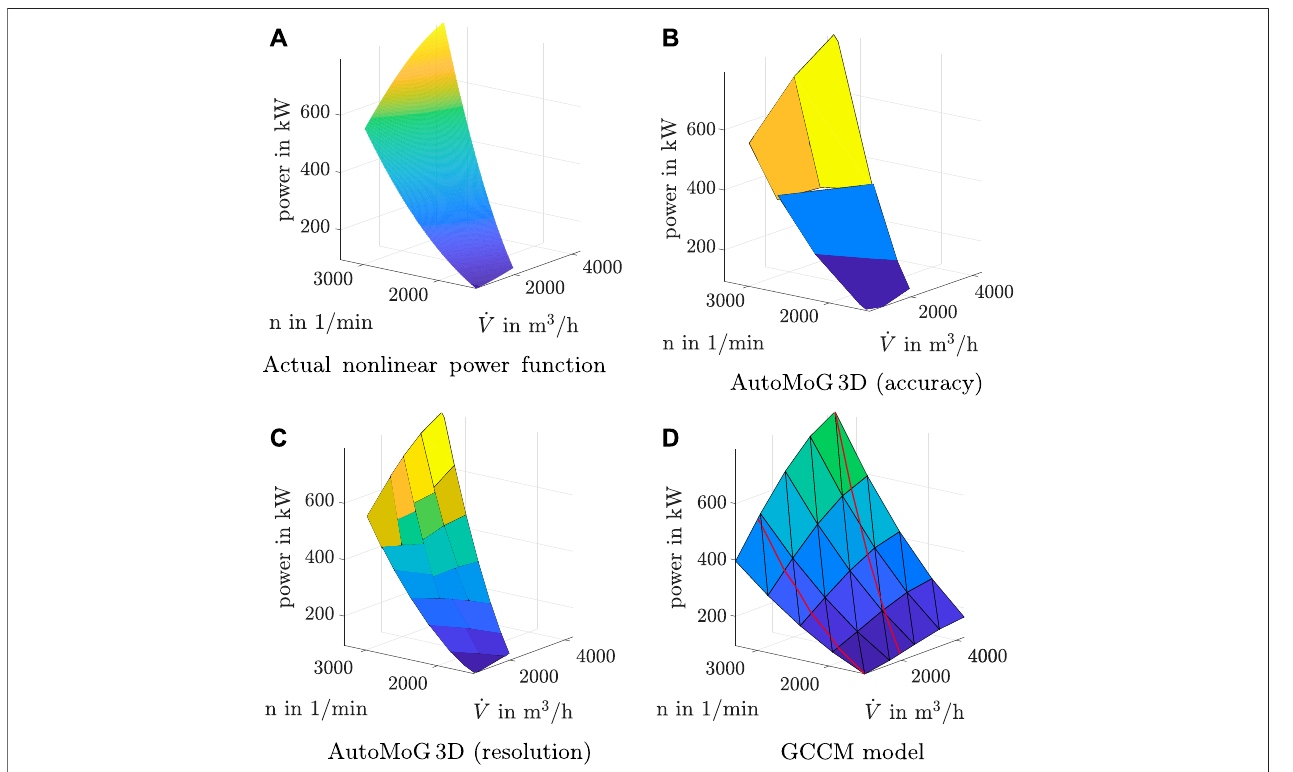
FIGURE 6 | Actual nonlinear power function of a variable-speed pump (A) , AutoMoG3D model with the same accuracy as the model of the generalized-convex- combinationmethod(GCCMmodel) (B) ,AutoMoG3DmodelwithacomparableresolutionastheGCCMmodel (C) ,andtheGCCMmodelusedbyBahletal.(2018) (D) . The power depends on the rotational speed n and the volumetric fl ow rate _ V . The generalized-convex-combination method needs a rectangular grid, whereas AutoMoG3Dautomaticallyconsiderstheactualoperating limitsofthepump. Theredlines in (D) showtheactualoperating limits.Thecolorcodeonlysupports the visual differentiation of the piecewise-af fi ne